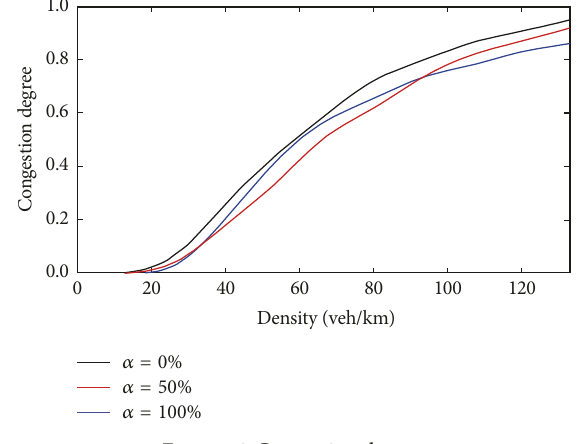
Figure 6: Congestion